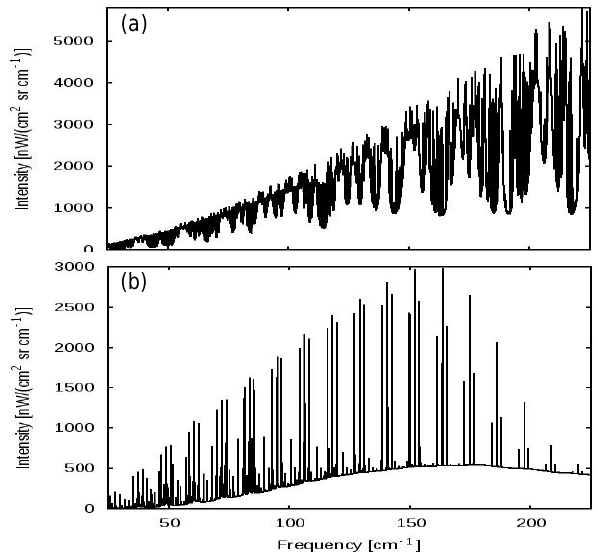
Figure 1. (a) Far-infrared atmospheric spectrum simulated at 20km tangent altitude, (b) same as upper panel but only O 2 is included in the